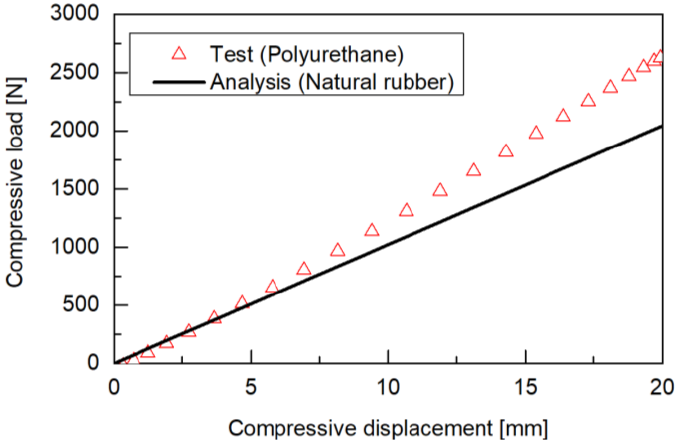
Figure 6. Comparison of compressive load displacement between natural rubber and polyure-